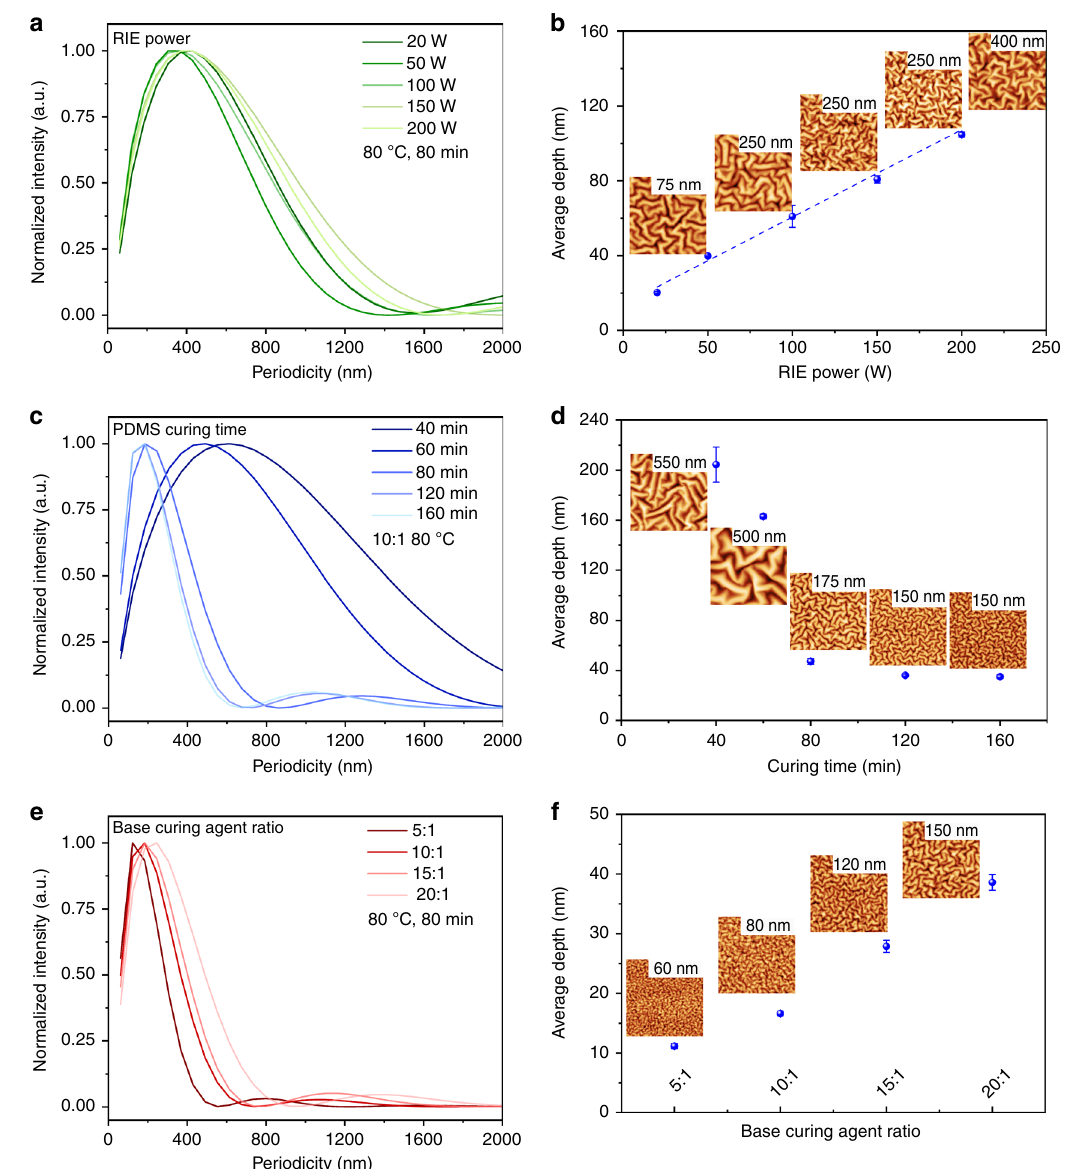
Fig. 2 The control of RIE-induced nanostructures. The in fl uence of the RIE power ( a , b ), the PDMS pretreatment time ( c , d ) and the weight ratio of the base and curing agent ( e , f ) on the periodicity distribution ( a , c , e ) and the average depth ( b , d , f ). The inset AFM fi gures are shown with a size of 5 μ m × 5 µ m, with different color scale from 0 nm to the maximum height marked for each fi gure. The detailed conditions for PDMS preparation and RIE treatment can be found in the method part. Error bar: the standard deviation from at least 3 AFM measurements on different